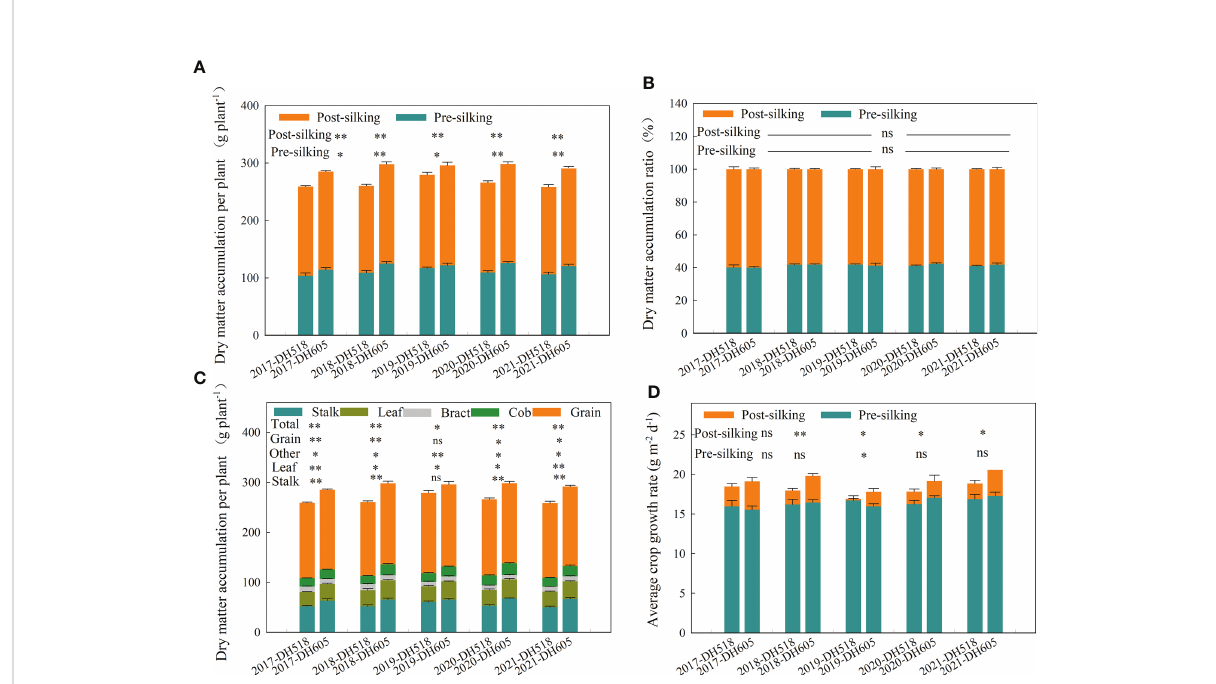
FIGURE 2 Above-ground biomass distribution and average crop growth rate of summer maize hybrids with different growth duration (2017-2021). 2017, 2018, 2019, 2020 and 2021 were different years; DH518, Denghai518; DH605, Denghai605. (A) Pre-silking and post-silking dry matter accumulation in aboveground biomass. Pre-silking and post-silking were the dry matter accumulation in aboveground biomass in that stage. (B) Pre-silking and post-silking dry matter accumulation ratio in aboveground biomass. Pre-silking and post-silking were the dry matter accumulation ratio` in aboveground biomass in that stage. (C) The dry matter distribution of different summer hybrids. Grain leaf and stalk were dry matter accumulation of each organ per plant; total were total dry matter accumulation per plant; other were dry matter accumulation of bract and cob per plant. (D) Average crop growth rate of different hybrids. Pre-silking and post-silking were average crop growth rate in that stage. ** and * indicated signi fi cantly different at the 0.01 and 0.05 probability levels, respectively; ns means there is no signi fi cantly different at the 0.05 probability levels,